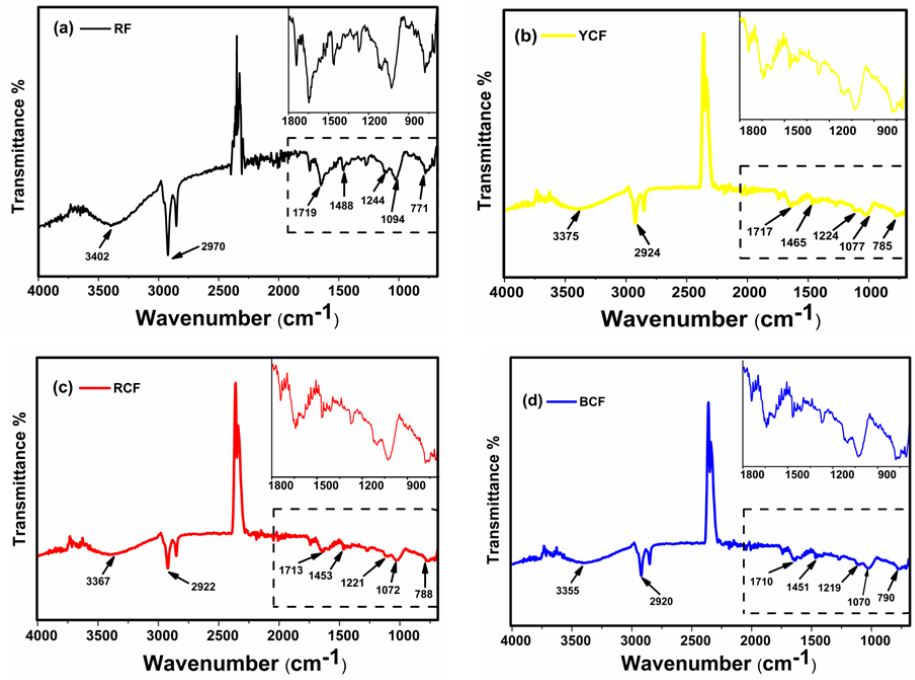
Figure 5. FT-IR spectra of: ( a ) RF; ( b ) YCF; ( c ) RCF; and ( d ) BCF.